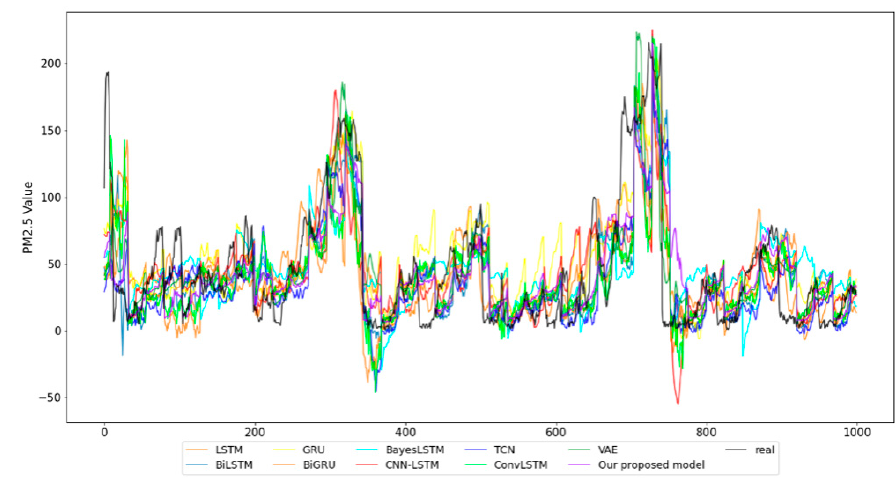
Figure 5. Plots of prediction results of different models on the PM2.5 dataset.